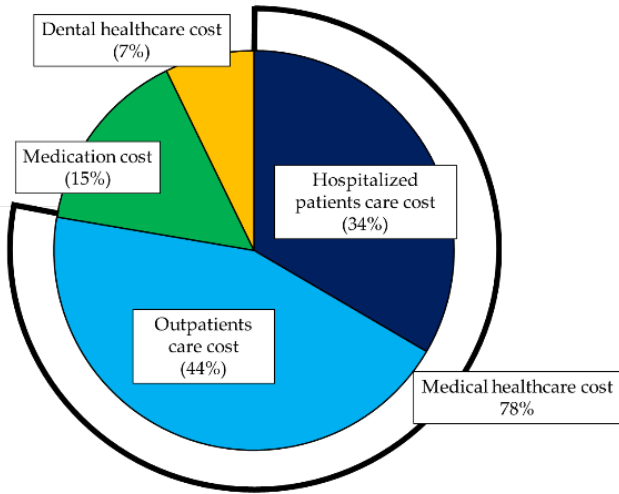
Figure 1. Total healthcare cost during 2017 to the first half of 2018.